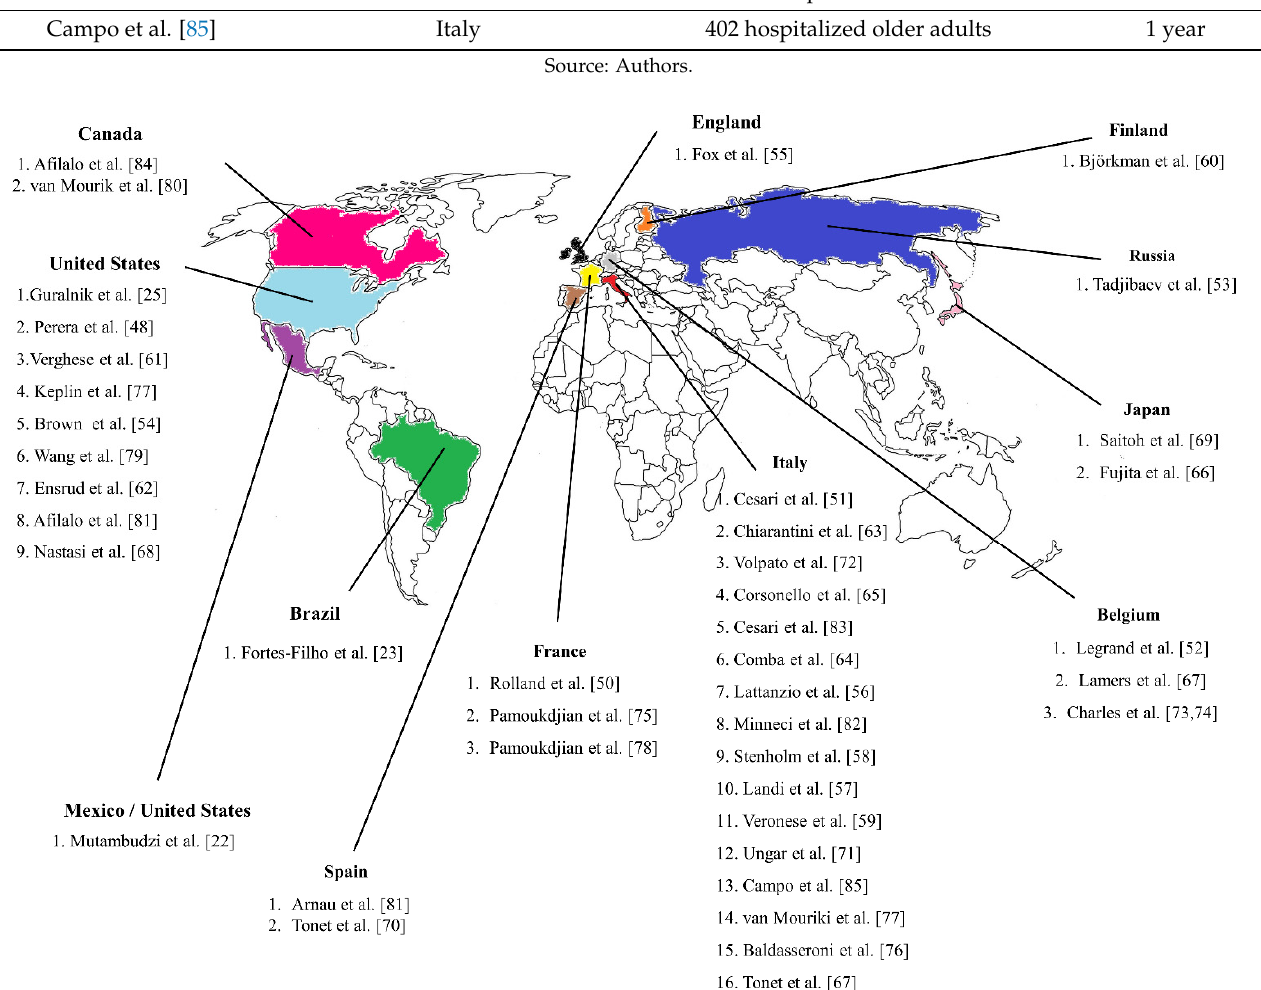
Figure 2. Distribution of longitudinal studies conducted with older adults on the SPPB and mortality according to research locations.